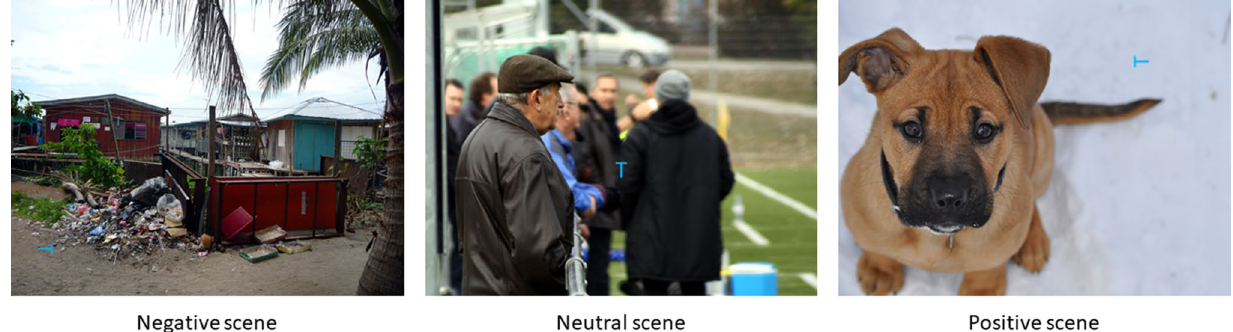
Figure 3. Representative examples of visual search stimuli. Targets were embedded within positive, neutral, and negative real-world scenes from the Nencki Affective Picture System 89